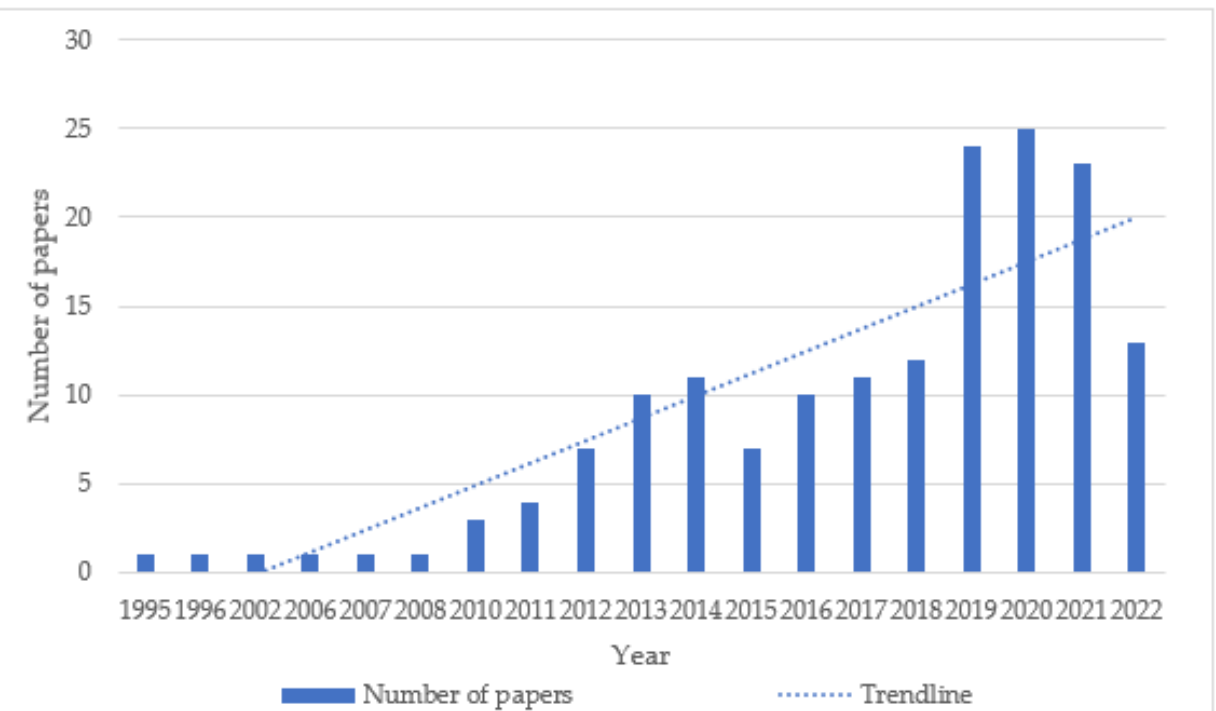
Table 1. The number of papers published per journal.